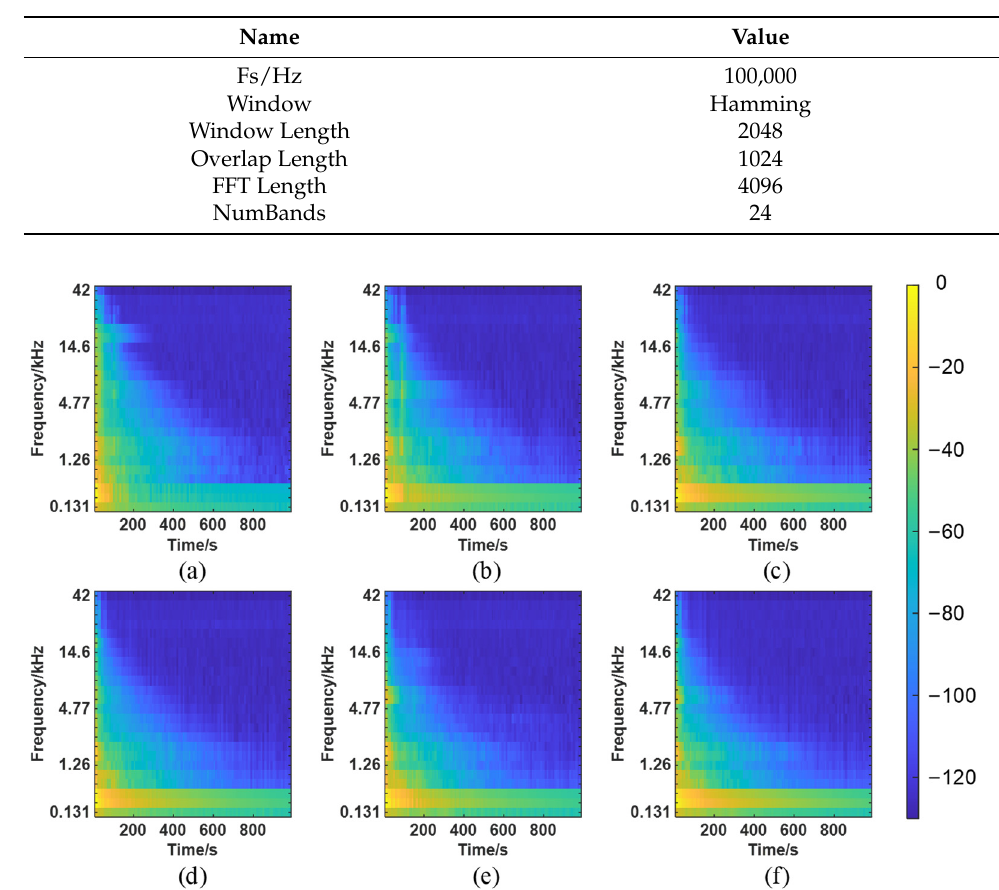
Figure 5. Mel spectrogram of 1 # pipeline for 6 cases: ( a ) 0 case; ( b ) 1 case; ( c ) 2 case; ( d ) 3 case; ( e ) 4 case; ( f ) 5 case.